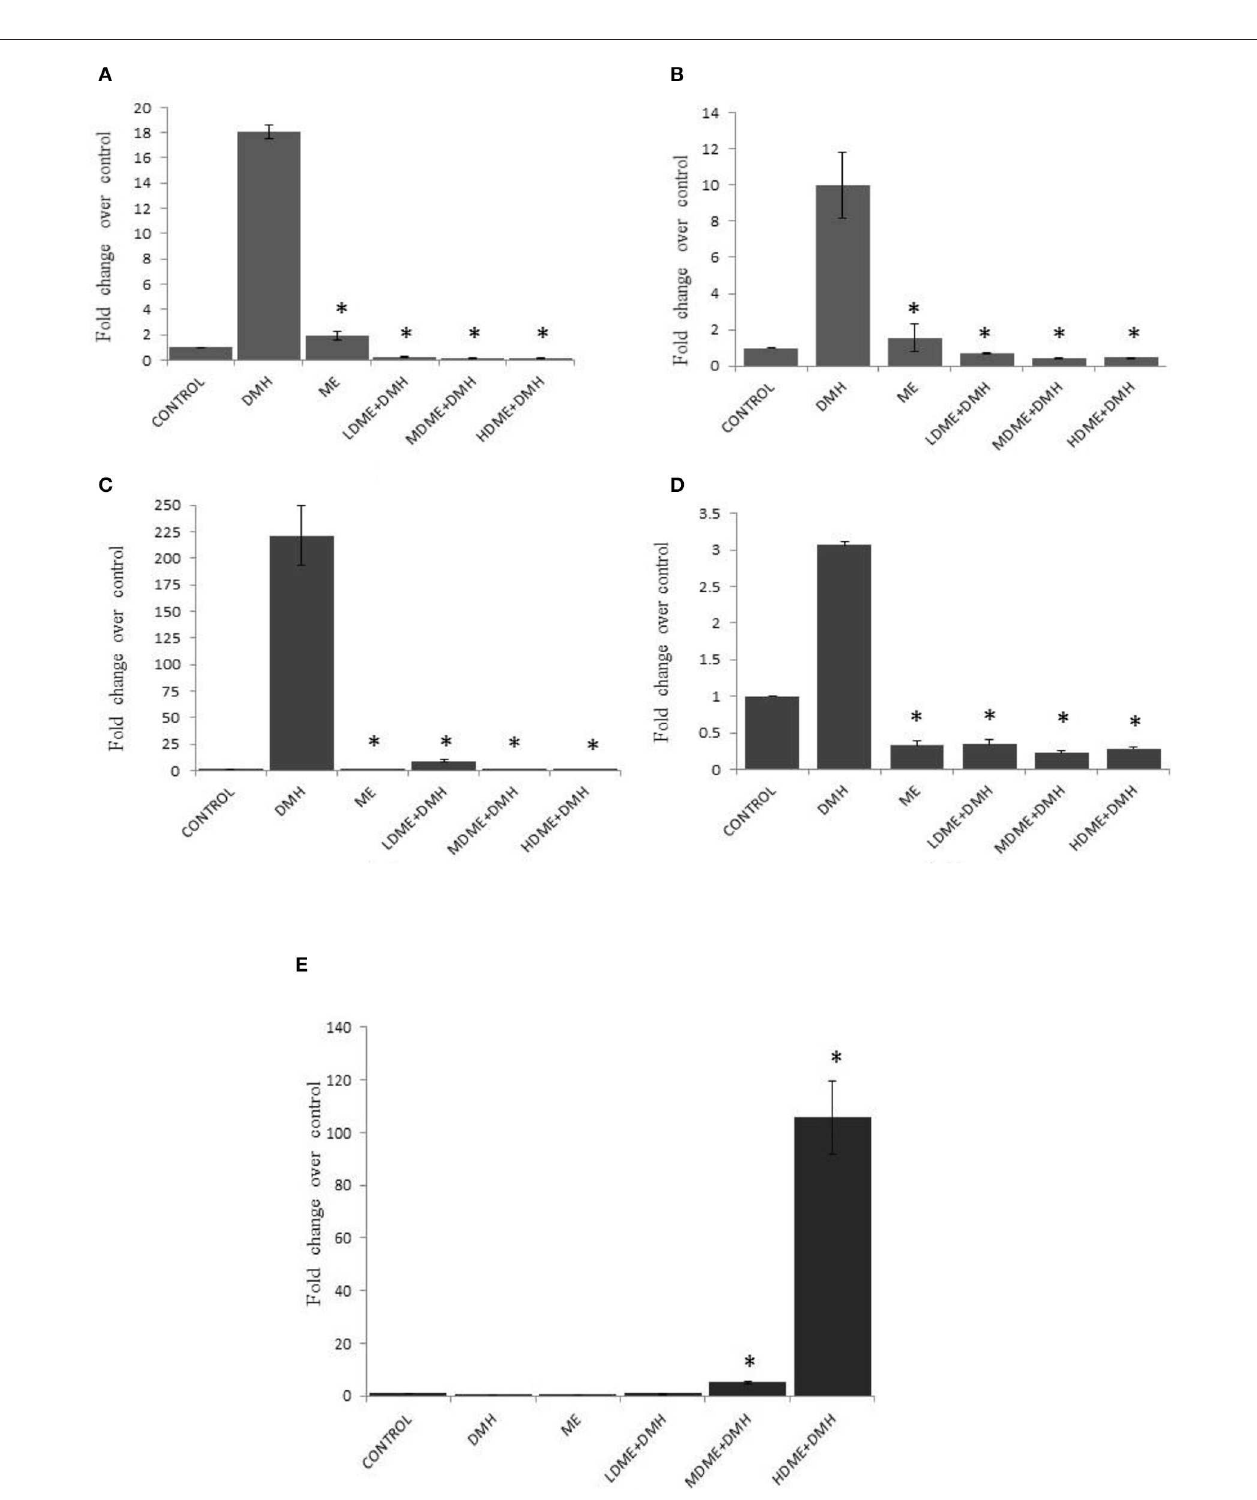
FIGURE 6 | Fold change in expression of molecular markers by real-time PCR in various groups of animals: (A) Cox-2, (B) β -catenin, (C) nuclear factor kappa B (NF- κ B), (D) K-ras, and (E) p53. Experiment was performed in triplicates. Values are expressed as mean ± SD, * p < 0.05 vs. 1,2-dimethylhydrazine (DMH)-treated.